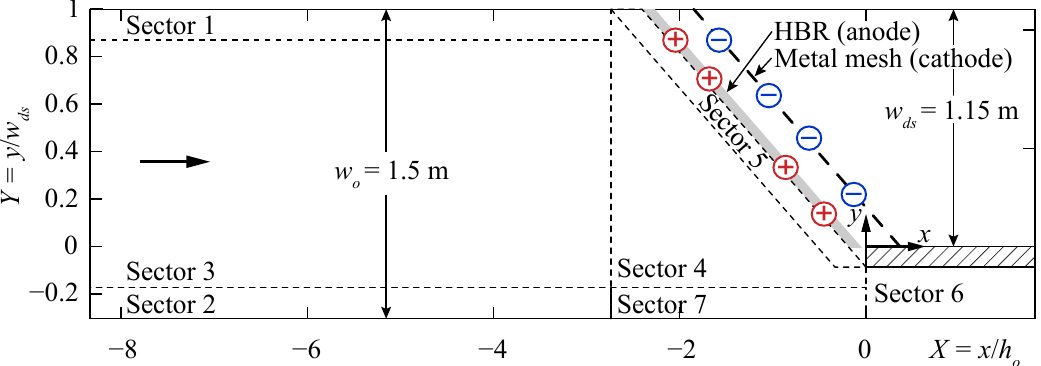
Figure 3. Definitions of sectors 1–7 of the laboratory channel (y-axis distorted by factor 2), where the electrified horizontal bar rack (e-HBR) is illustrated with plus symbols (anode) and the metal mesh with minus symbols